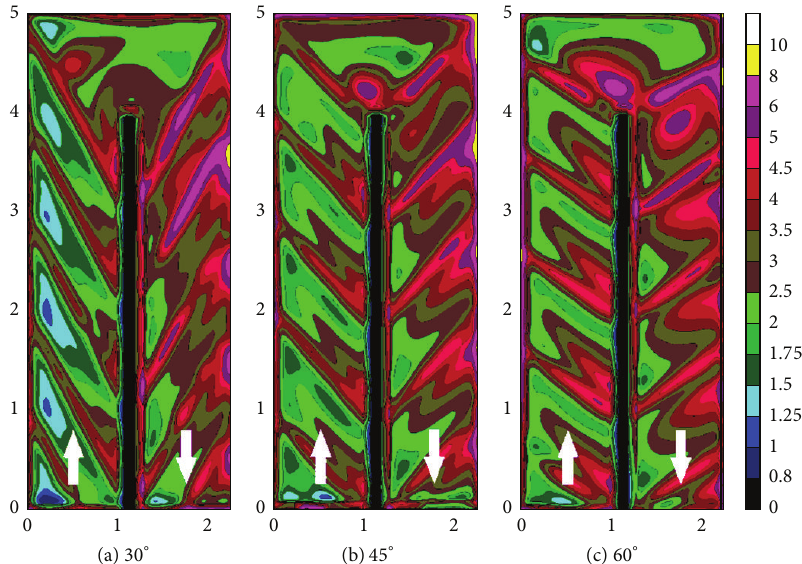
Figure 9: Nu / Nu ∗ distribution for a channel with superimposed ribs, Re = 30,000, symmetric heating, 𝑝/𝑒 = 10 , and various rib angles 𝛿 ; adapted from Astarita et al.